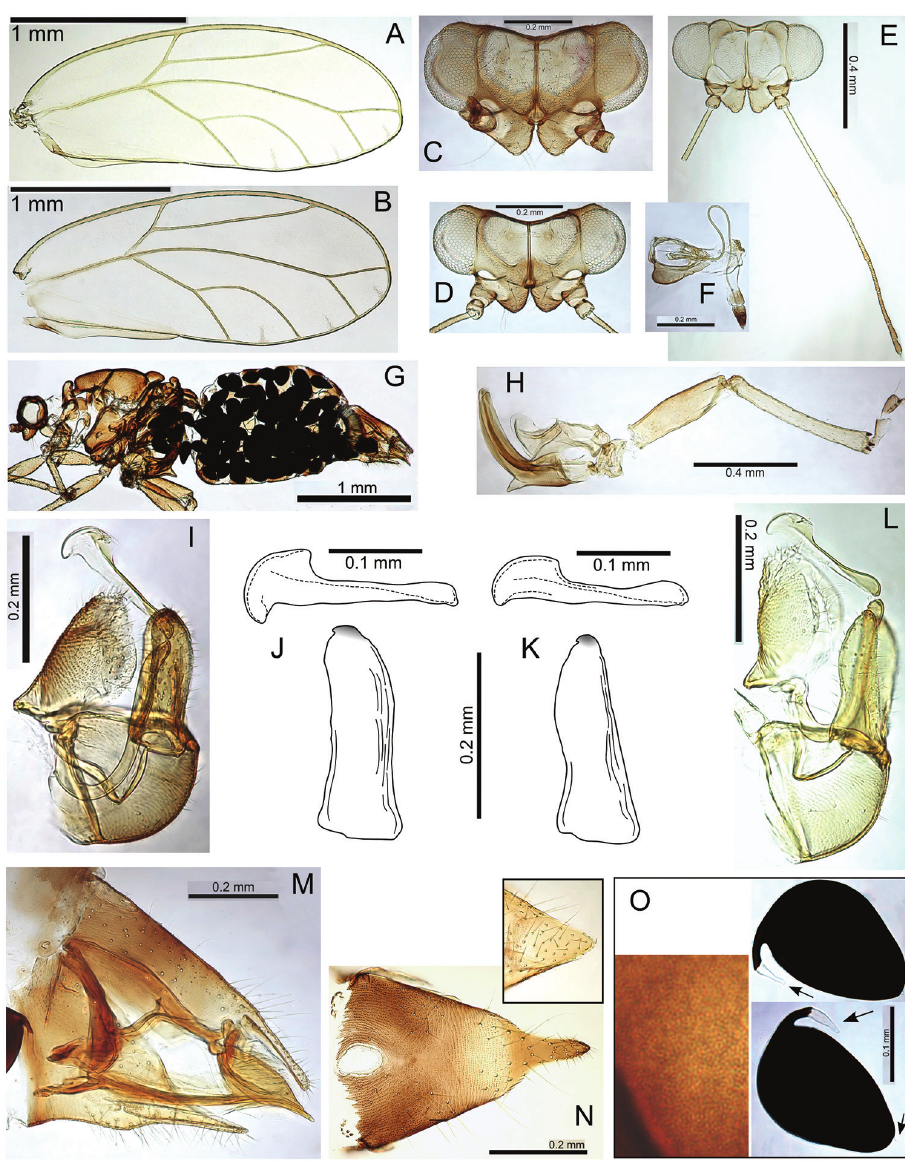
Figure 40. Pariaconus montgomeri sp. n. A, B fore wing: A form montgomeri B form paliuliensis C, D head: C form montgomeri D form paliuliensis E head and antenna F proboscis G female with abdomen full of eggs H hind leg I, J form paliuliensis : I male terminalia J aedeagus and paramere K, L, M, N, O form montgomeri : K aedeagus and paramere L male terminalia M female terminalia N female proctiger (dorsal view) with apex of subgenital plate (ventral view, inset) O eggs (pedicel and tail indicated, microsculpturing